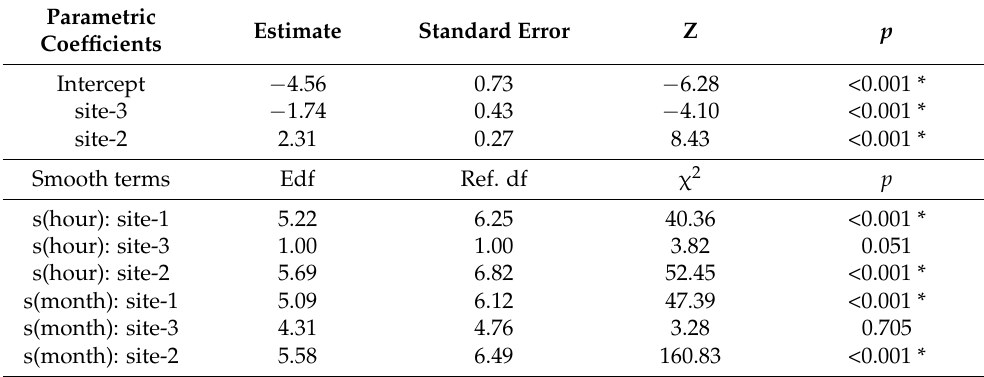
Table 4. The table below summarizes a negative binomial GAM model used to examine the effect of recording time and month on H. sparverioides ’s activity. The recording hour and month were modeled independently with smoothed function for each monitored site, while the cyclic predictor was modeled using a cyclic cubic regression spline. Reference degrees of freedom was used to calculate test statistics and p -values are represented by Ref. df, whereas Edf (Effective degrees of freedom) indicates the curviness of the